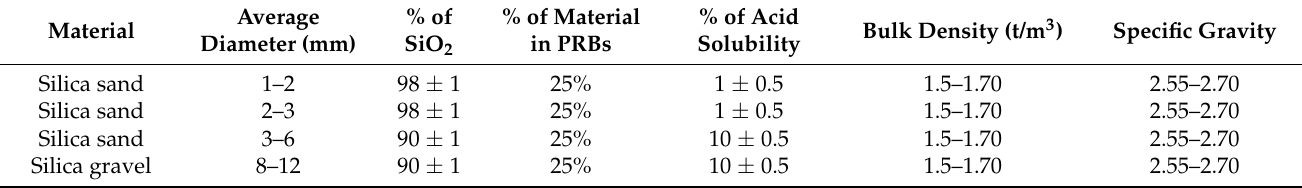
Table 1. Properties of filling material used in permeable reactive barriers (PRBs).